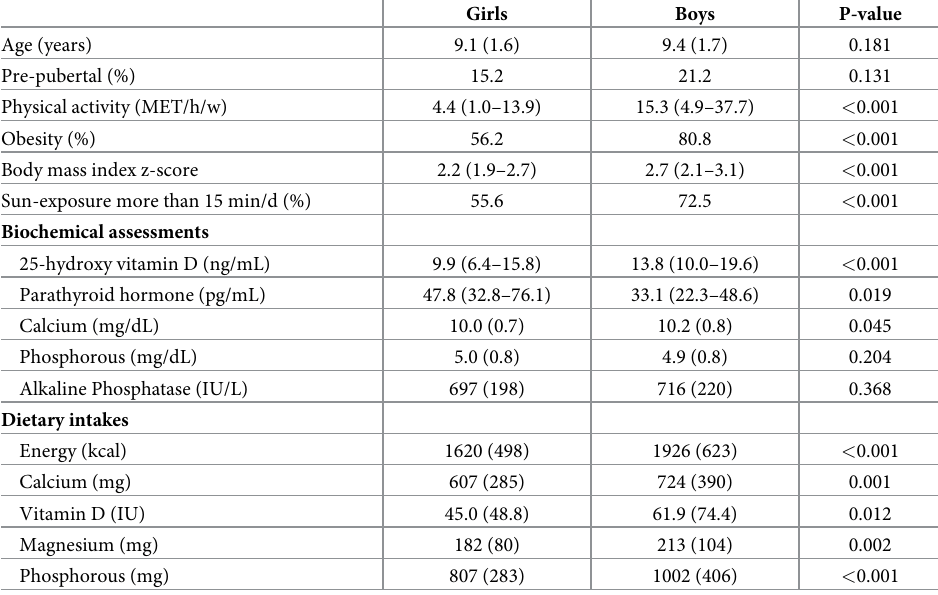
Table 1. Baseline characteristics of participants according to